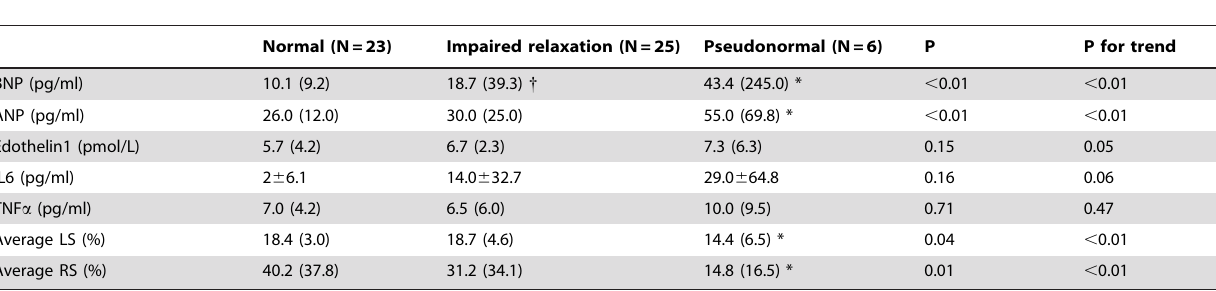
Table 4. Serum and myocardial strain according to diastolic function classification in patients with Chagas